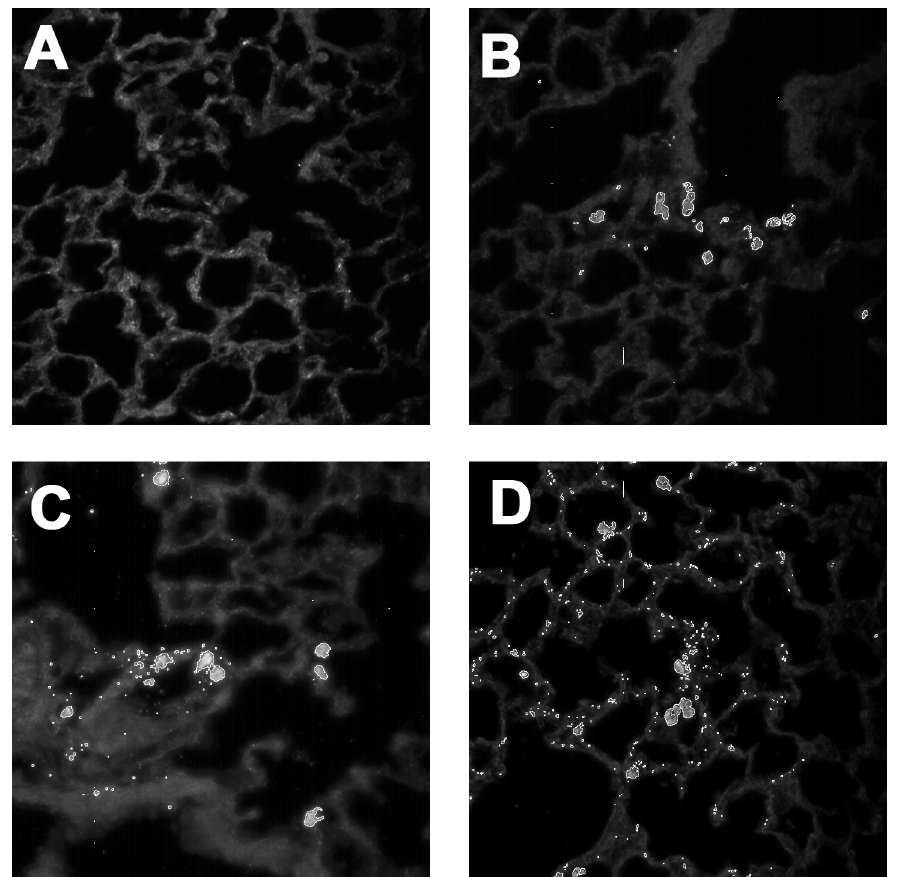
Figure 5. CytoViva dark-field images (400×) using Particle Fitting Function to locate MWCNT in lung tissue following a three-day particle exposure: ( A ) no particle dispersion media control; ( B ) source MWCNTs isolated mainly in alveolar macrophages. ( C ) carboxylated MWCNT 20.6 (20 min) starting to show some distribution in the lung lining in addition to AM cell collection; and ( D ) maximally carboxylated MWCNT 14.7 (120 min) demonstrates particle dispersion throughout the lung lining indicating epithelial cell involvement.